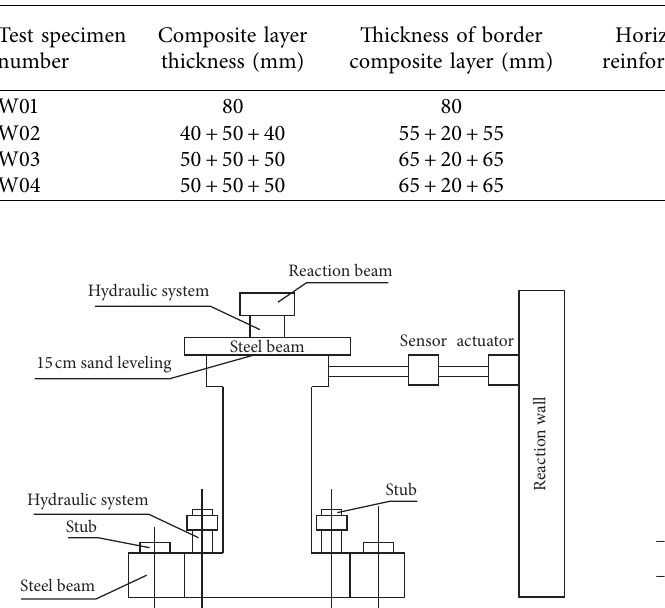
Figure 2: Loading device.